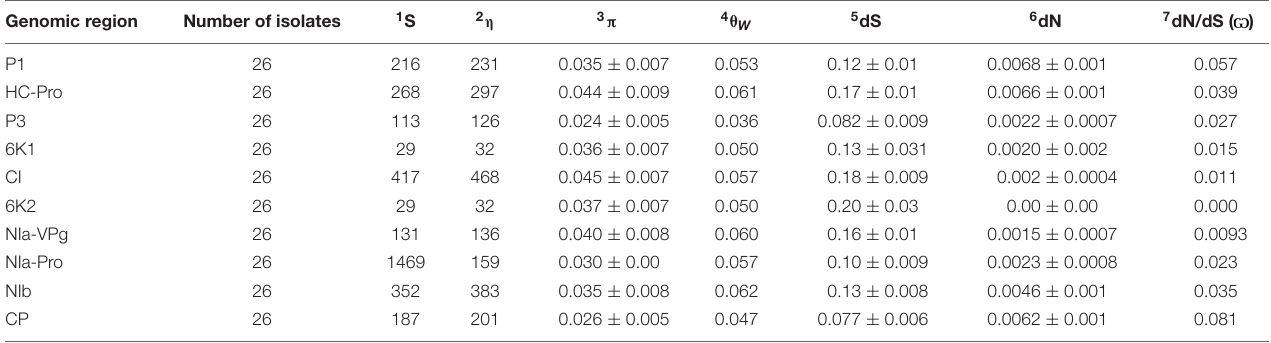
TABLE 1 | Population genetics parameters calculated using DnaSP and MEGA for encoded regions of Kansas WSMV isolates. Genomic region Number of isolates